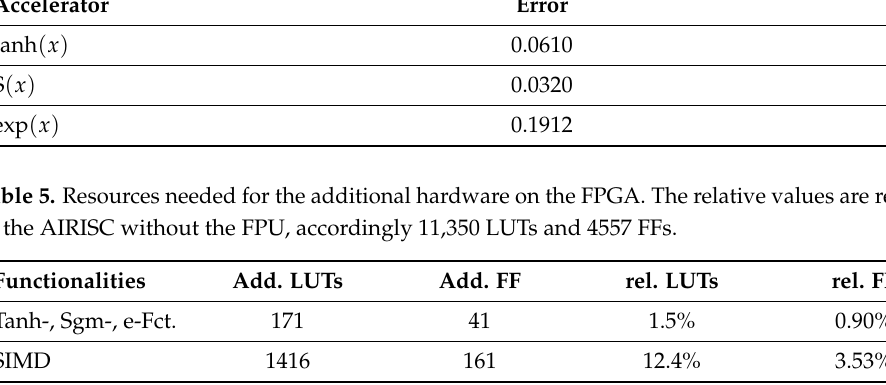
[ 1 : 1 ] for the accelerators compared to the ∈ −